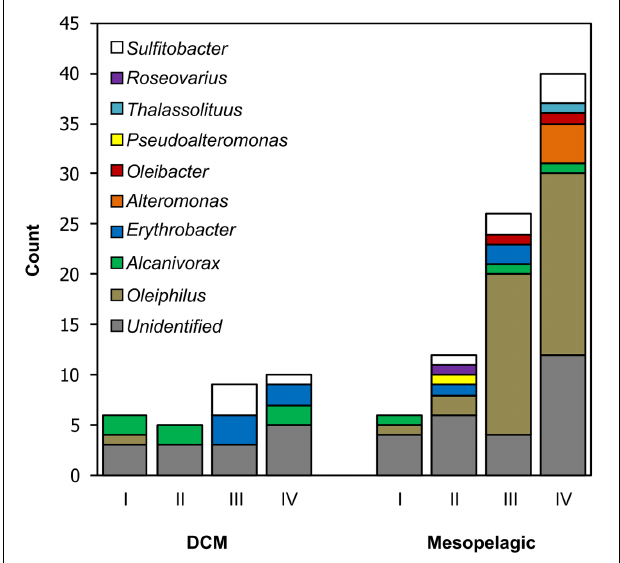
FIGURE 1 | Number and identity of bacterial isolates obtained in dilution-to-extinction culturing experiments. Column I represents control samples lacking HMWDOM amendments and columns II–IV indicate samples with HMWDOM amendments: treatment II: 7.2 mg L − 1 ; treatment III: 18 mg L − 1 ; treatment IV: 7.2 mg L − 1 (purified HMWDOM polysaccharides). The column height indicates the number of isolates that were viable and sub-cultured and the column color code indicates the SSU rRNA gene-based identification of isolates. Unidentified samples were positive wells that did not remain viable after sub-culturing and could not be sequenced. The total column height indicates the number of positive wells ( > 1 × 10 4 cells mL − 1 ) originally detected in the flow cytometry growth